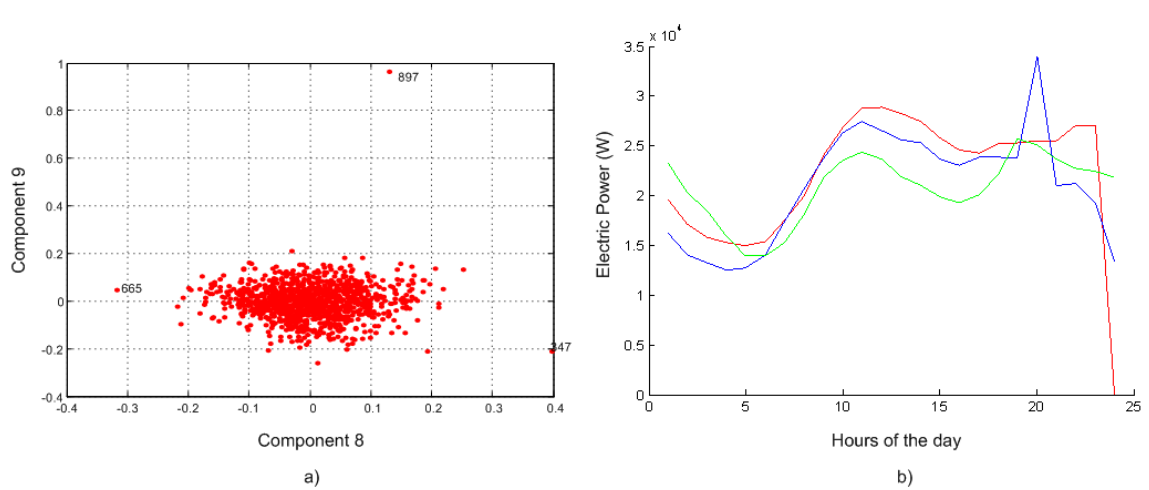
Figure 6. ( a ) PCA Analysis: component 8 and 9. ( b ) Blue: 665, Red: 897 and Green: 347; the number means the number of pattern in the data